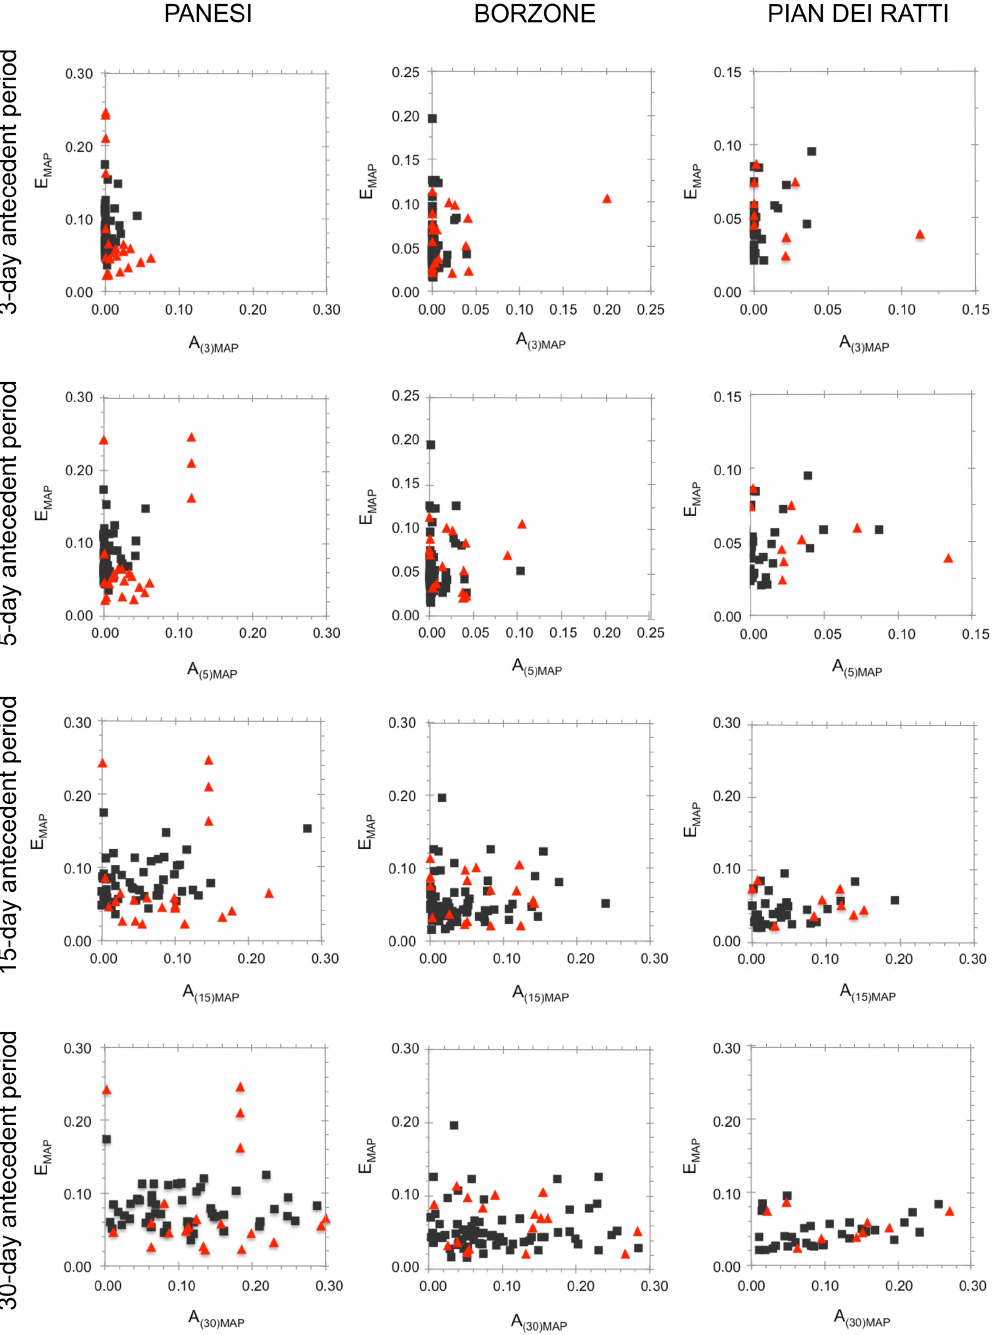
Figure 8. Relationship between the MAP-normalized cumulated event rainfall E MAP , and the MAP-normalized antecedent rainfall A (d) MAP , for 3-, 5-, 15- and 30-day antecedent periods, for the Panesi, Borzone and Pian dei Ratti rain gauges. See Fig. 1 for location of the rain gauges. Red triangles show rainfall events with shallow landslides or earth flow (Table 1), and black squares show rainfall events that did not trigger landslides or for which the occurrence of landslides is